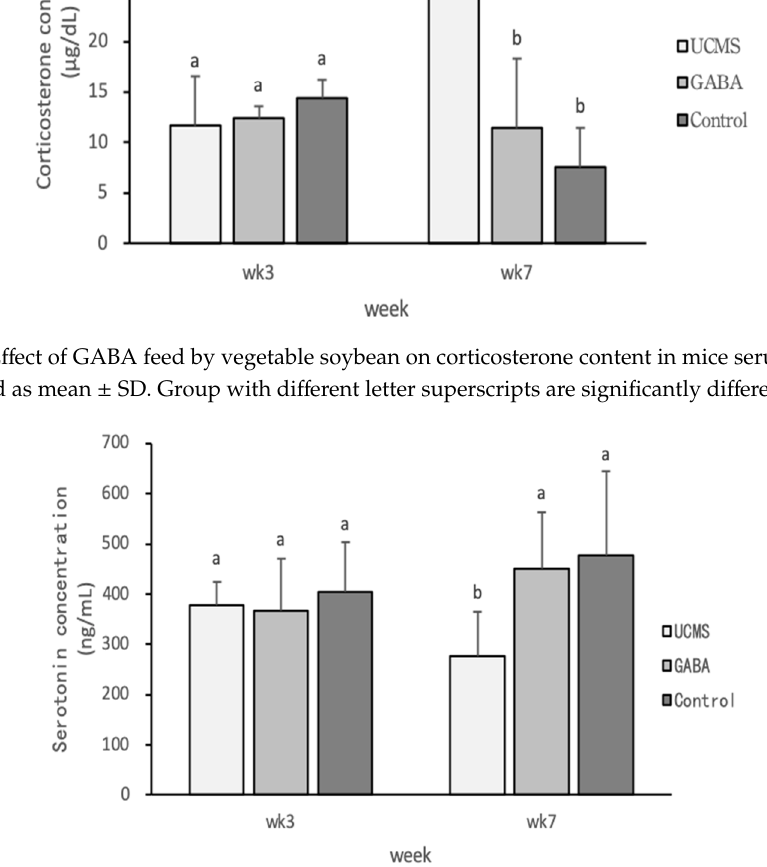
Figure 8. Effect of GABA feed made by vegetable soybean on serotonin content in mice serum. Data are represented as mean ±SD. Group with different letter superscripts are significantly different ( p < 0.05).